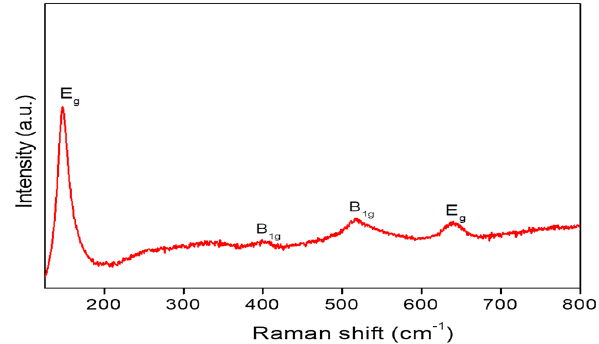
Fig. 3 Raman spectrum of the B-TiO